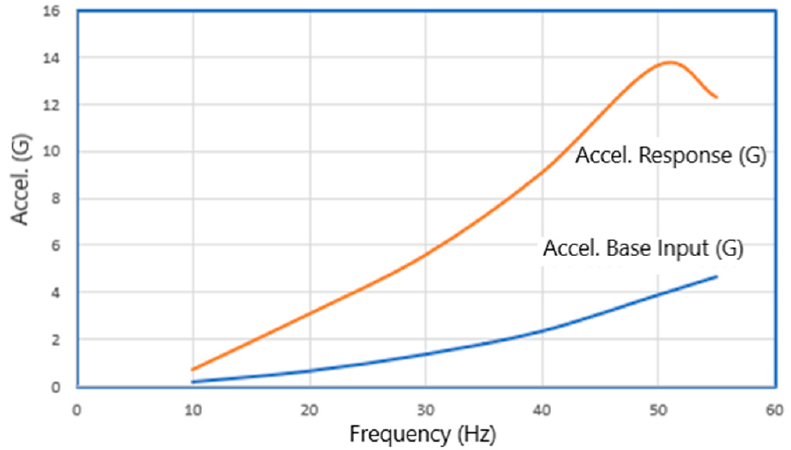
Figure 7. PSD of acceleration base input and acceleration response.